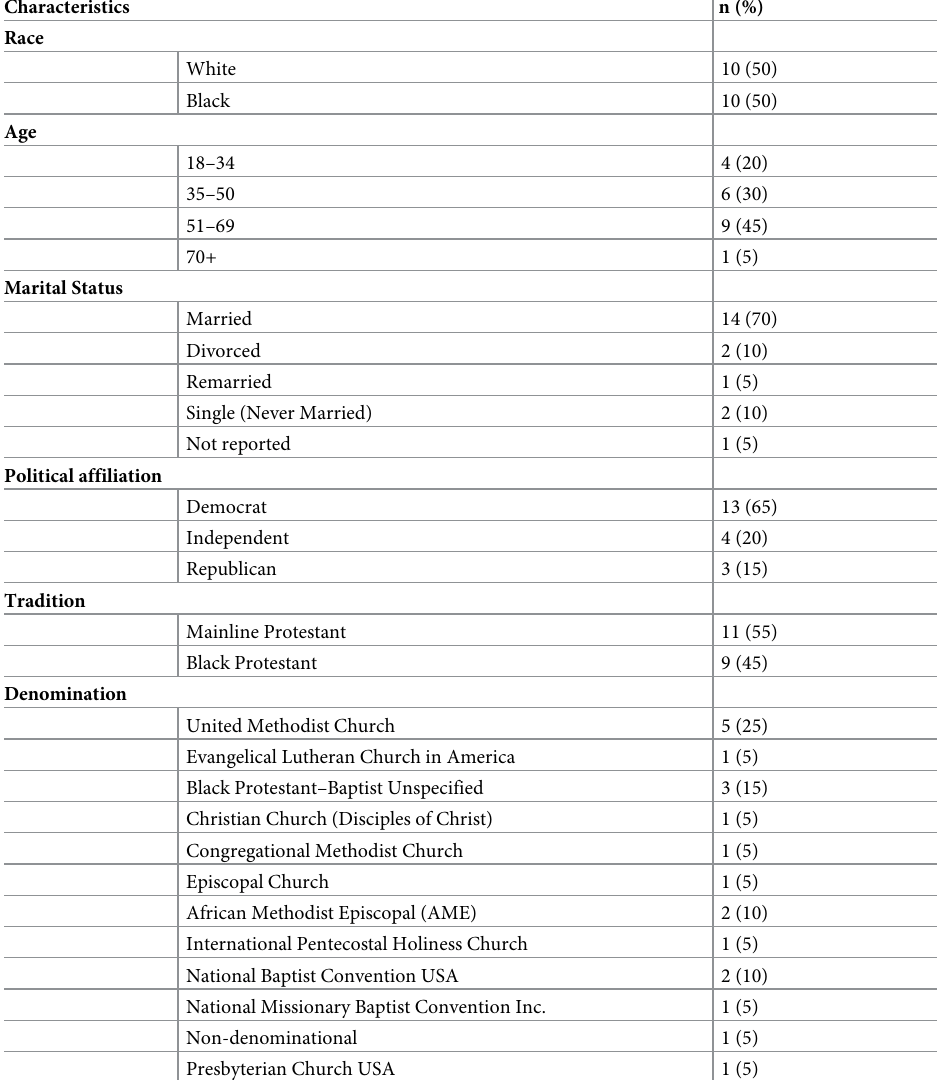
Table 1. Socio-demographic characteristics of religious